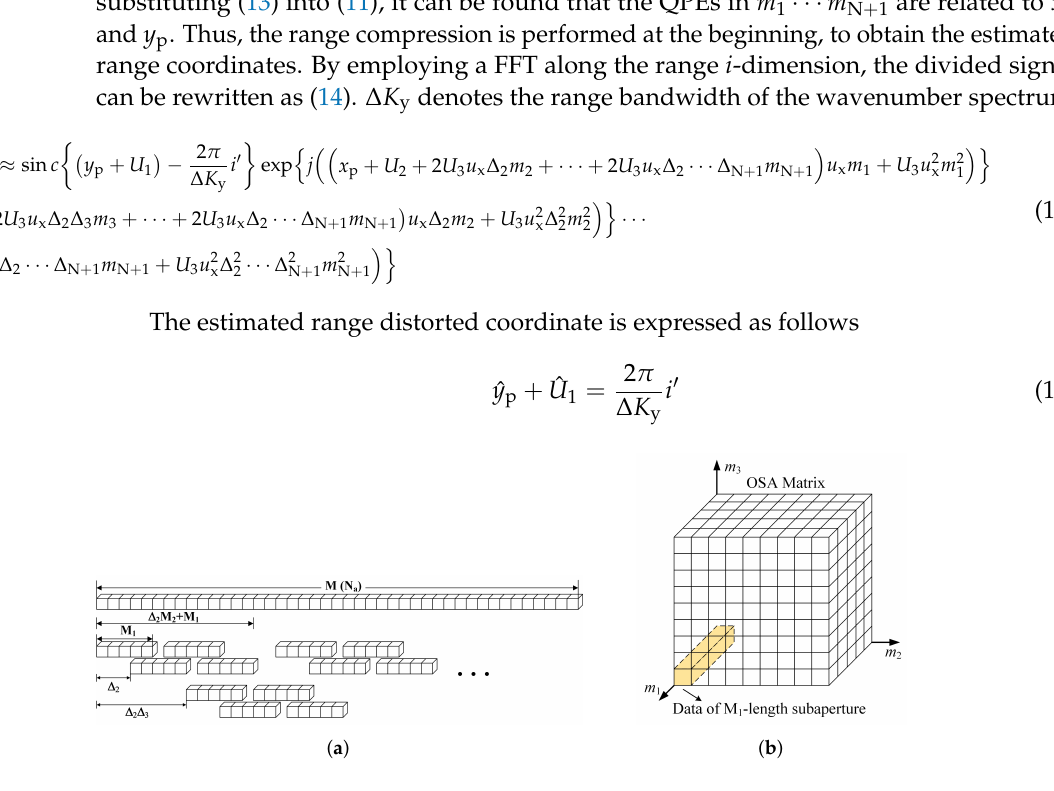
Figure 8. Subaperture ( a ) division and ( b ) combination by taking two-layer processing as an